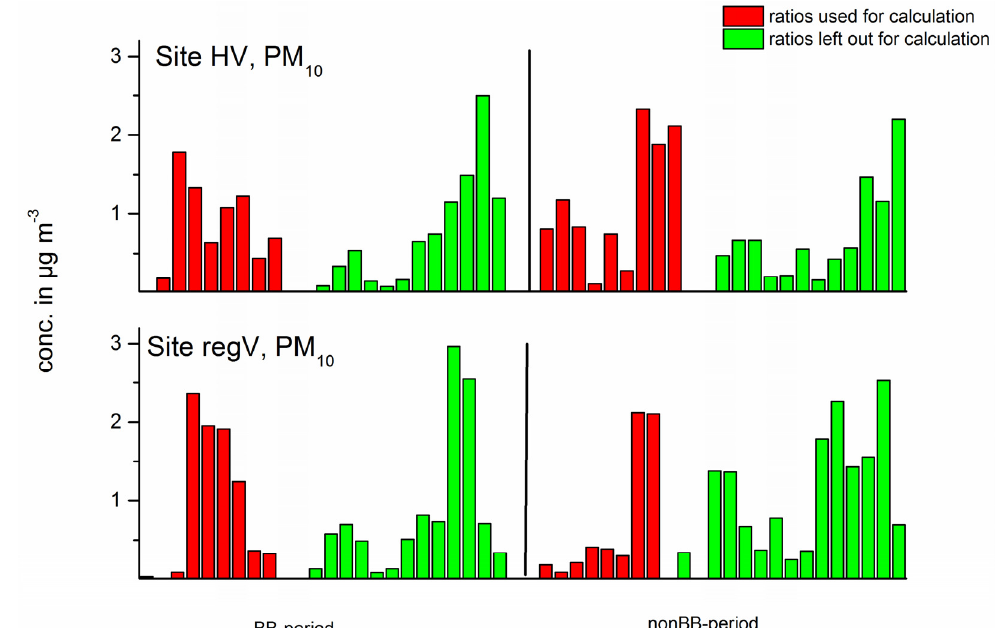
Figure 5. Primary biogenic carbon (POC BB- and nonBB-period (obtained from PMF-analysis